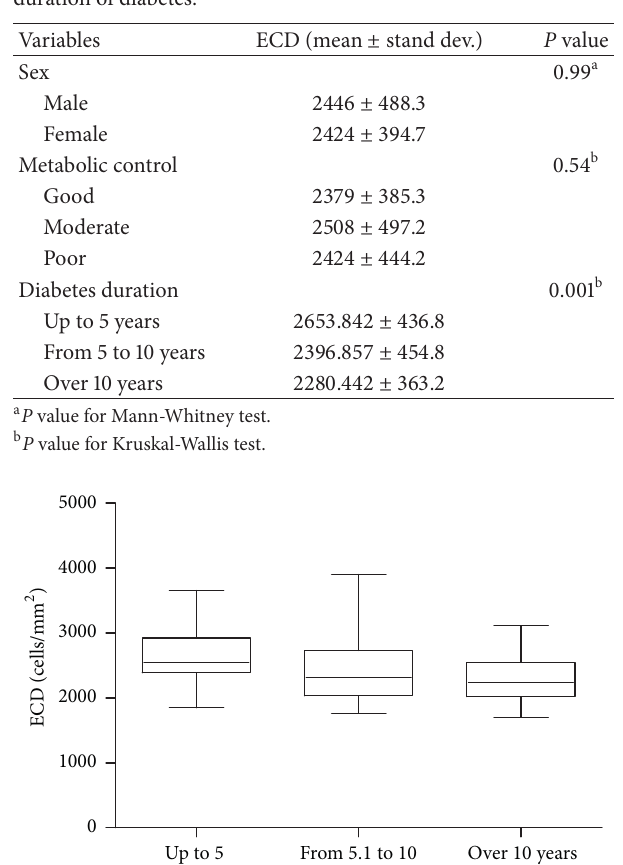
Table 1: Mean ECD values in relation to sex, metabolic control, and duration of diabetes.